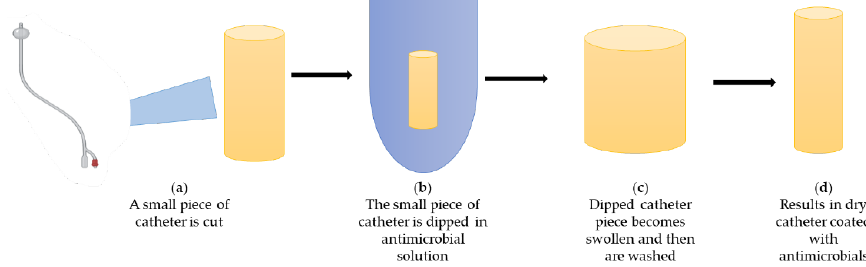
Figure 7. Description of incorporation of antimicrobial coating on urinary catheters.